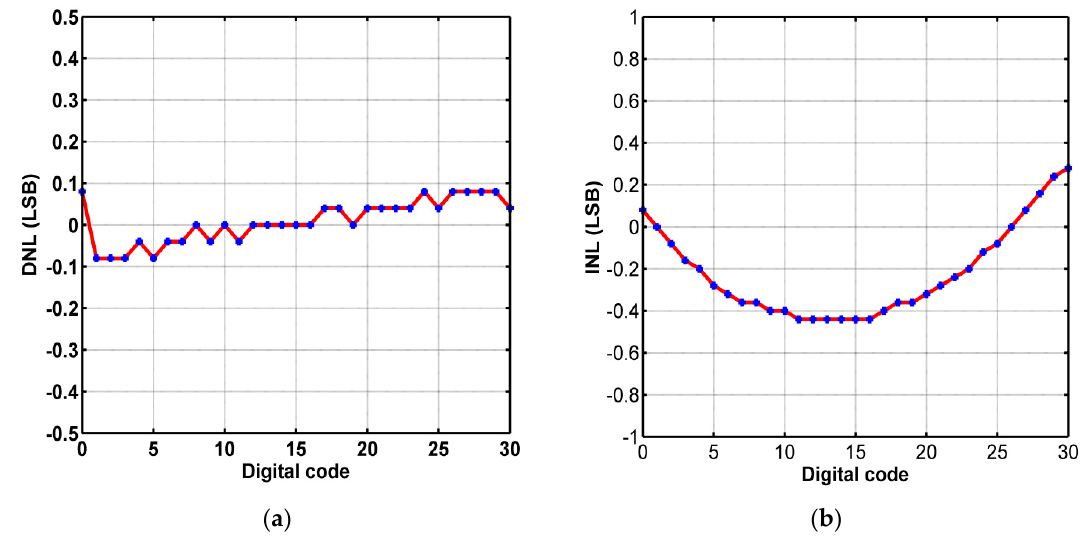
Figure25. ( a )Differentialnon-linearity(DNL)forthefirstproposedADC,and( b )integralnon-linearity(INL) for the first proposed ADC.